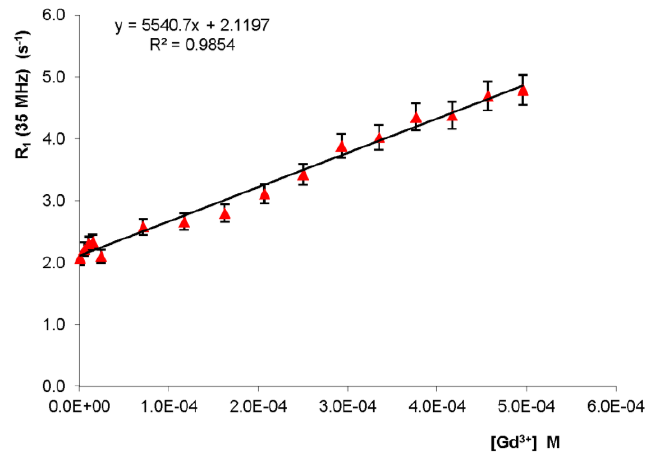
Figure 2. 1 H NMR relaxation rate (R 1 ) of a rat heart homogenized with standard addition of Gd 3+ and linear fitting.